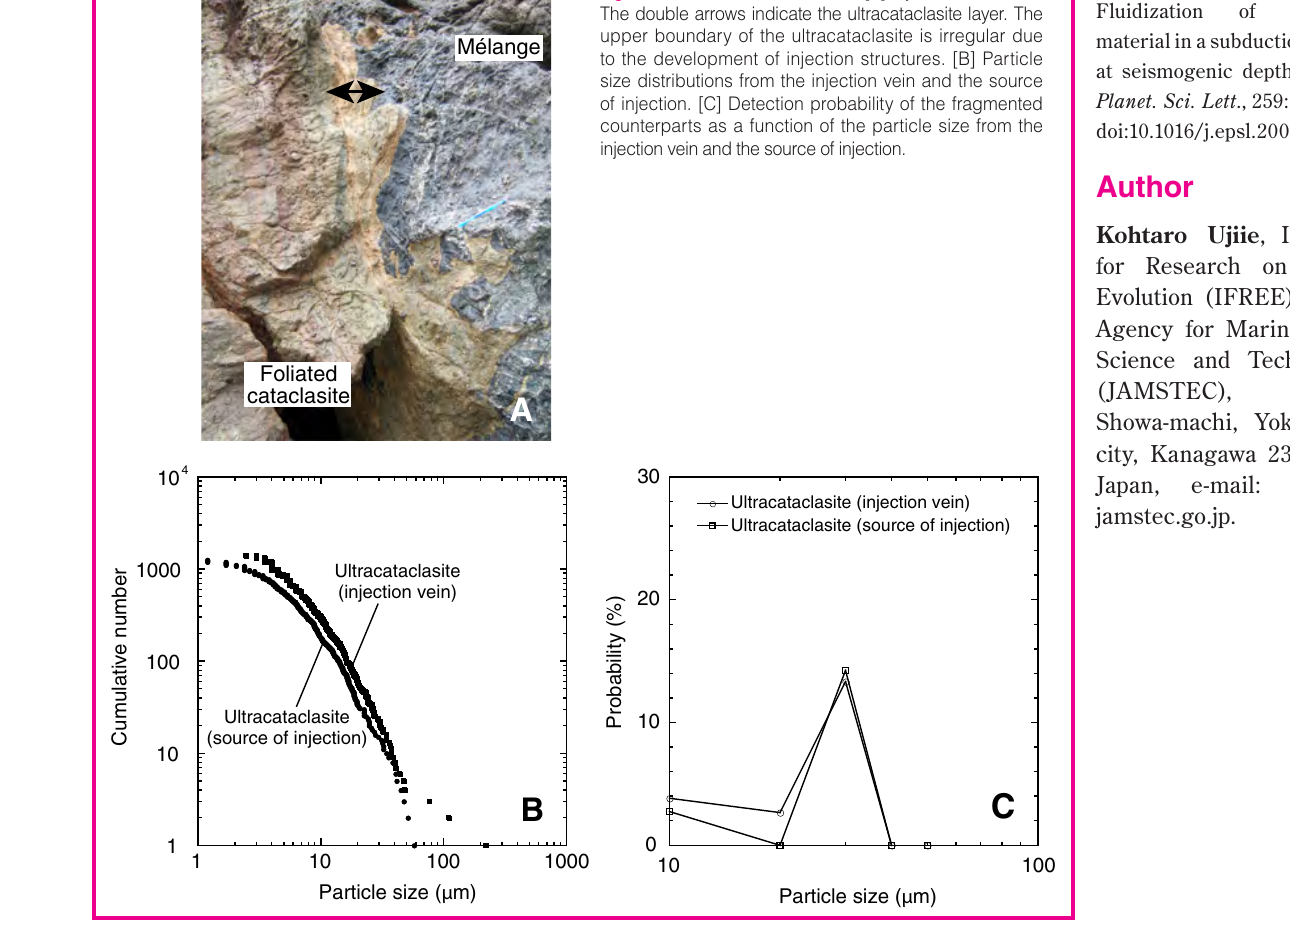
Figure 3. Evidence of fluidization. [A] Injection structures. The double arrows indicate the ultracataclasite layer. The upper boundary of the ultracataclasite is irregular due to the development of injection structures. [B] Particle size distributions from the injection vein and the source of injection. [C] Detection probability of the fragmented counterparts as a function of the particle size from the injection vein and the source of